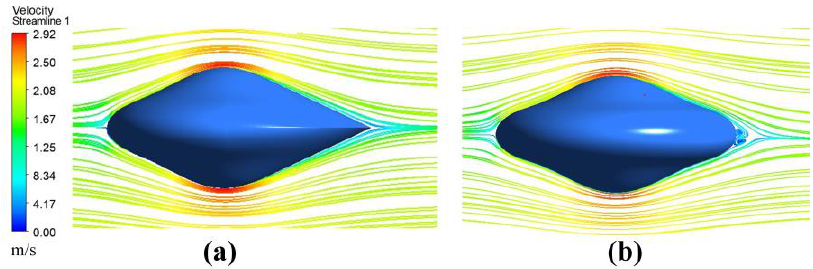
Figure 6. Streamlines of AUH in 𝑥𝑜𝑧 plane at a velocity of 2 m/s and an AOA of 10 degrees ( a ) for HG3 and ( b ) for HG1.